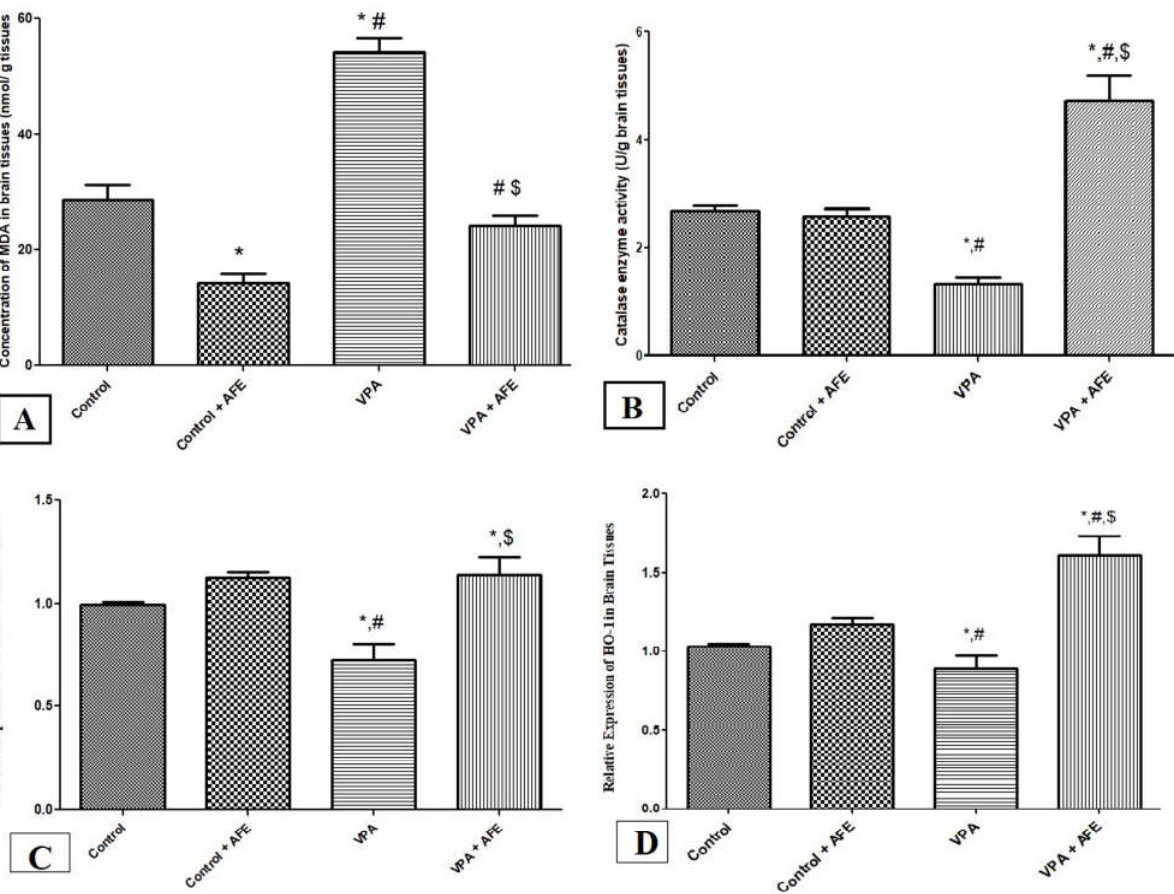
Figure 3. Effect of AFE on oxidative stress markers (MDA and catalase) and the expression of antioxidant genes (Nrf2 and HO-1). The effect of AFE on the concentration of MDA (marker of lipid peroxidation) ( A ), catalase enzyme (antioxidant enzyme) ( B ), expression of Nrf2 at mRNA ( C ) and expression of HO-1 at mRNA levels ( D ). Data are expressed as mean ± SEM. * significant vs. control group, # significant vs. control + AFE group, $ significant vs. VPA group. p ≤ 0.05 is considered